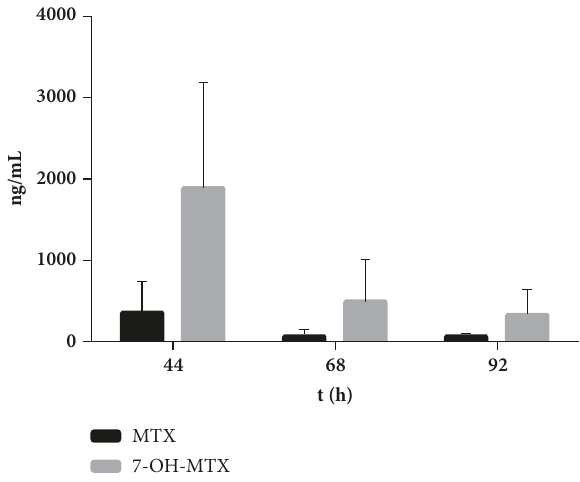
Figure 4: Determined concentrations of MTX and 7-OH-MTX (Mean ±